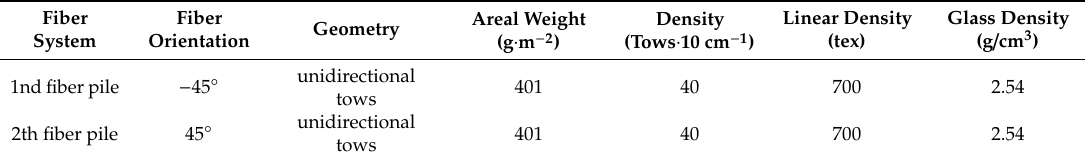
Table 2. Geometric parameters of biaxial NCF (E-DB800).